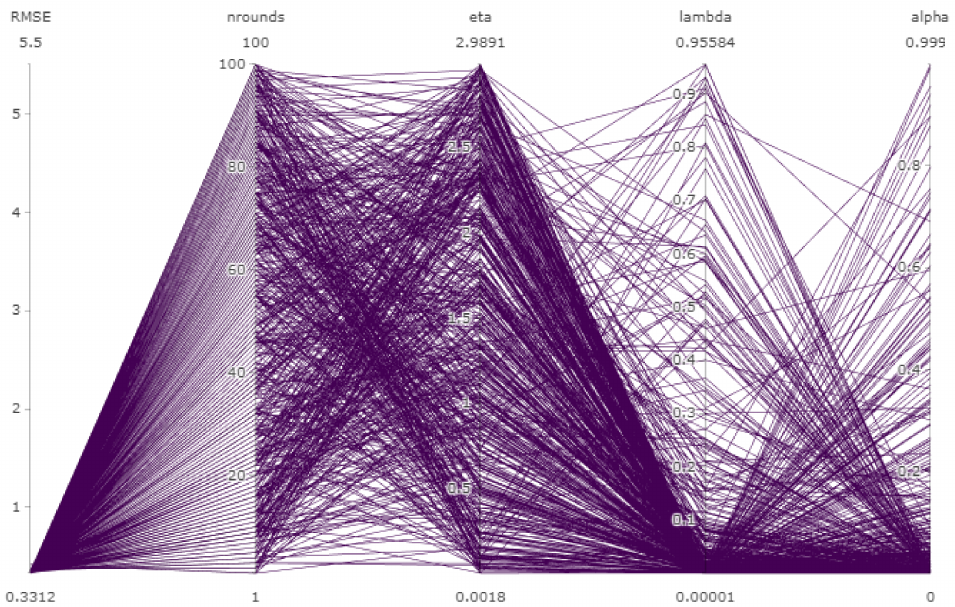
Figure 5. Interactions between hyperparameter values based on the random search algorithm in the extreme gradient-boosting model.